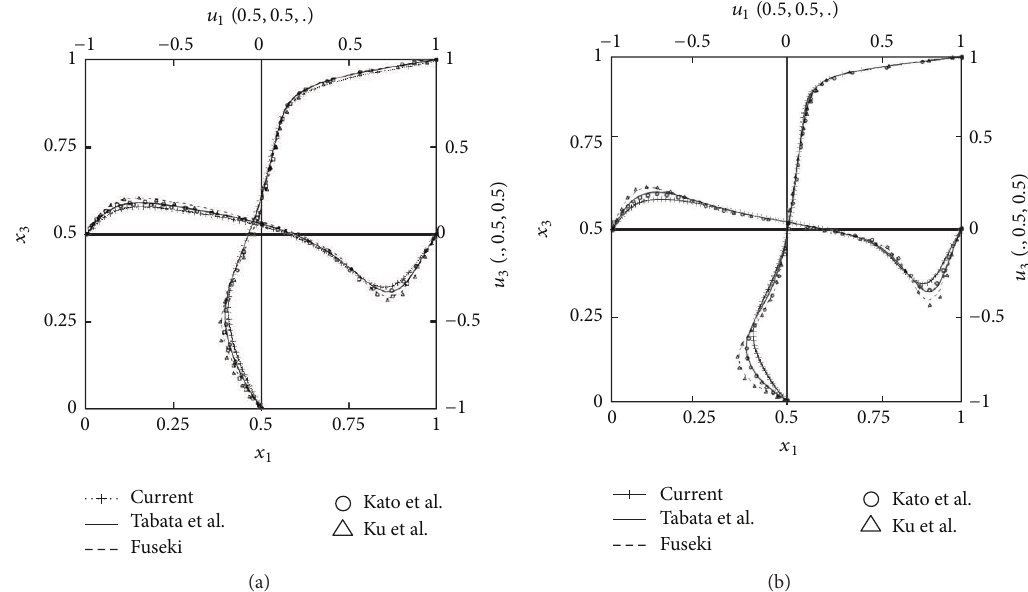
Figure 4: Comparison of 𝑢 1 and 𝑢 3 at the plane of 𝑥 2 = 0.5 . ((a): 50 × 50 × 50 , Re = 400; (b): 80 × 80 × 80 , Re = 1,000).